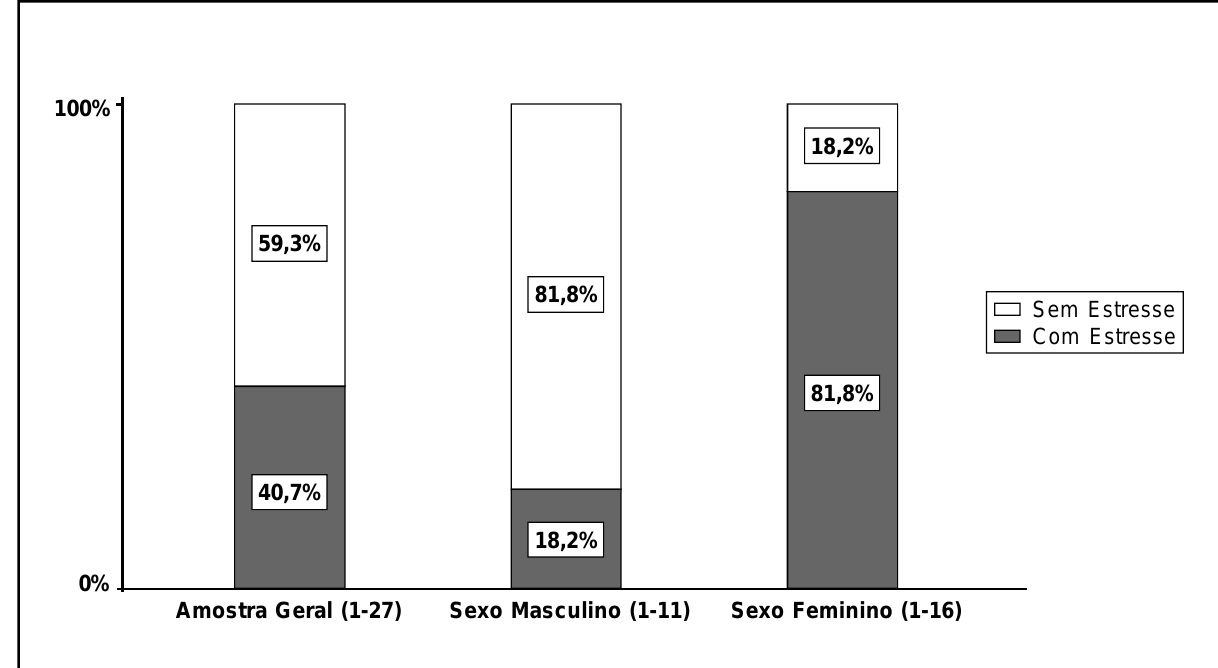
Figura 2. Distribuição da ocorrência do estresse na amostra geral e por sexo ( n =27).